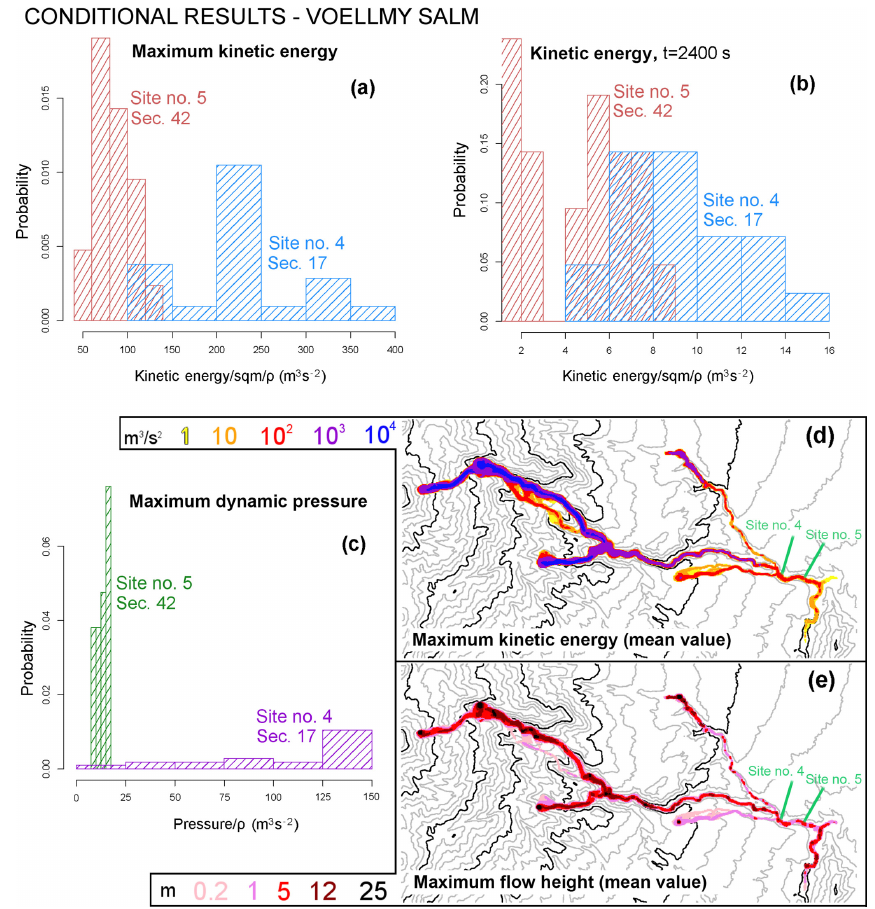
Figure 17. Flow properties of the VS model, over the input space e (cid:50) VS . Histograms of (a, b) local kinetic energy and (c) dynamic pressure 2 at sites 4 and 5, (a) at t = 2400s and with (b, c) maximum value. Different sites are displayed with different colors. Mean values over e (cid:50) VS 2 of the maps of maximum (d) kinetic energy and (e) flow height as a function of time. Colors are related to their values. Elevation contours are included at intervals of 100m (gray) and 500m (black) (NASA – JPL, 2014). Sites 4 and 5 are